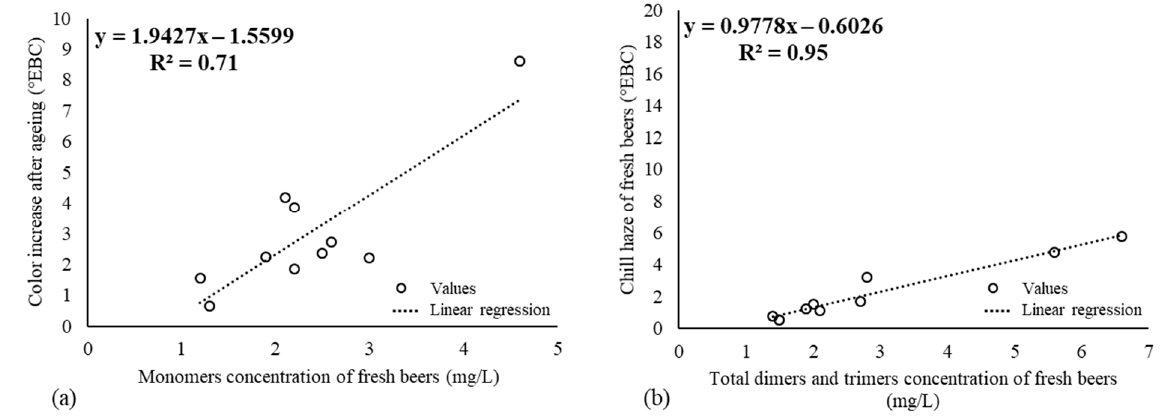
Figure 4. Correlations between ( a ) (+)-catechin and (-)-epicatechin level in fresh beers (mg/L) and color increase (°EBC) after one year at 20 °C; ( b ) Flavan-3-ol dimers and trimers concentration (mg/L) and chill haze of fresh beers (°EBC).